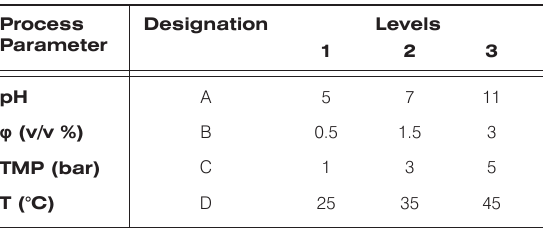
Table 3. The design of experiment for the L Experiment